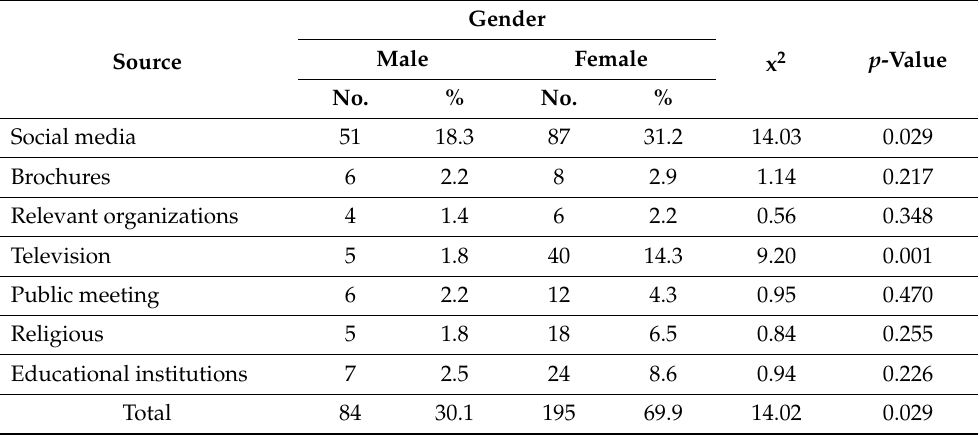
Table 7. Household source of information related to waste segregation and recycling.